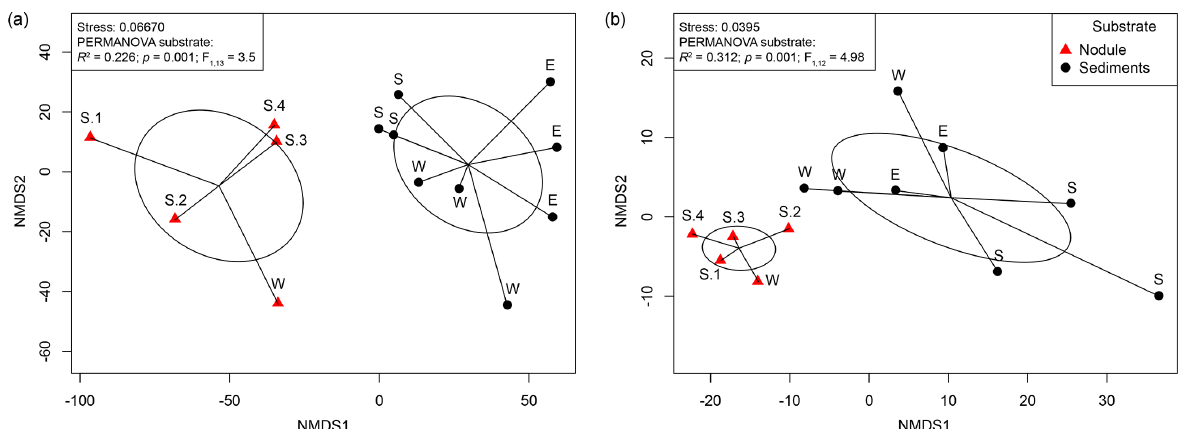
Figure 2. Non-metric multidimensional scaling (NMDS) plot based on a Euclidean distance similarity matrix of (a) bacterial- and (b) archaeal-community structure at the OTU level. Sequence abundances of OTUs were CLR-transformed. Permutational multivariate analysis of variance (PERMANOVA) showed significant differences between nodule- and sediment-associated microbial communities (for details see Table S1 in the Supplement). Each sample (dot) is connected to the weighted averaged mean of the inter-group distances. Ellipses represent one standard deviation of the weighted averaged mean.